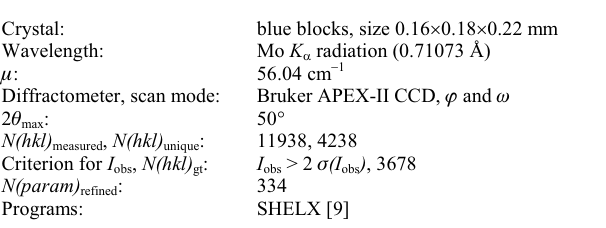
Table 1. Data collection and handling.